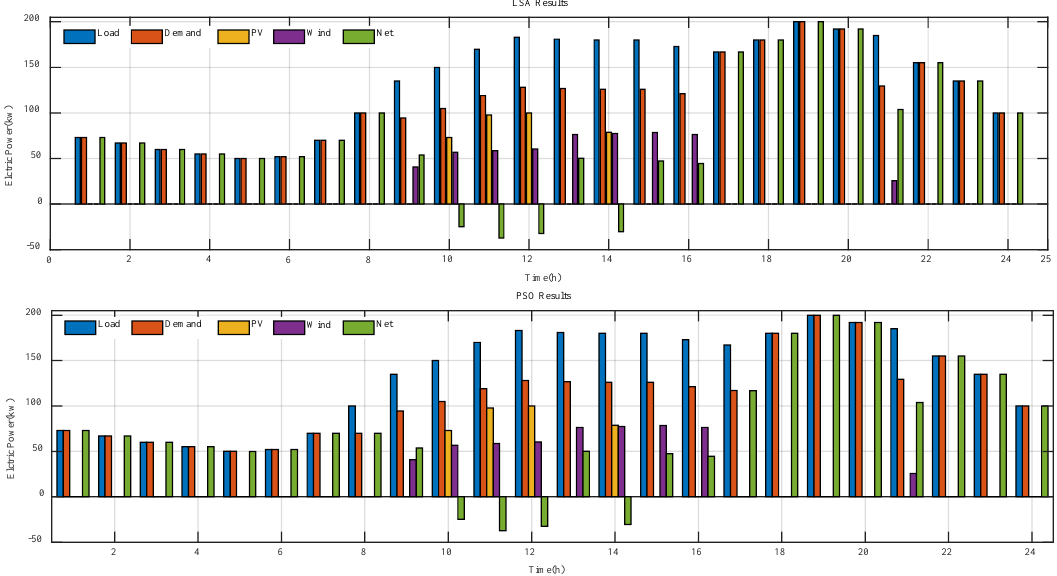
Figure 11. Power produced by PV and WT, and exchanged power with network.